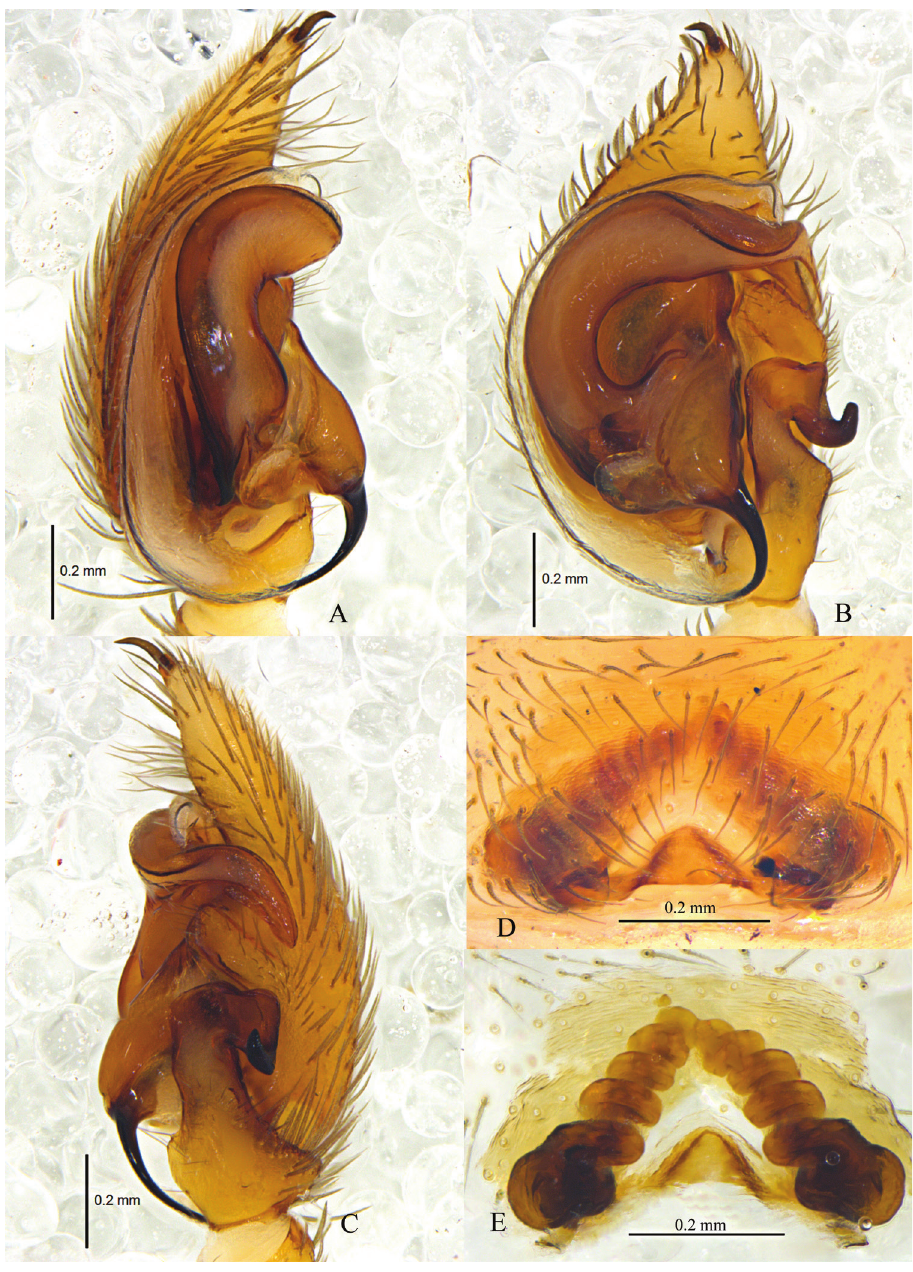
Figure 2. Zodarion apertum sp. n., male holotype left palp ( A–C ) and female paratype ( D, E ) A Prolat- eral view B Ventral view C Retrolateral view D Epigynum, ventral view E Vulva, dorsal